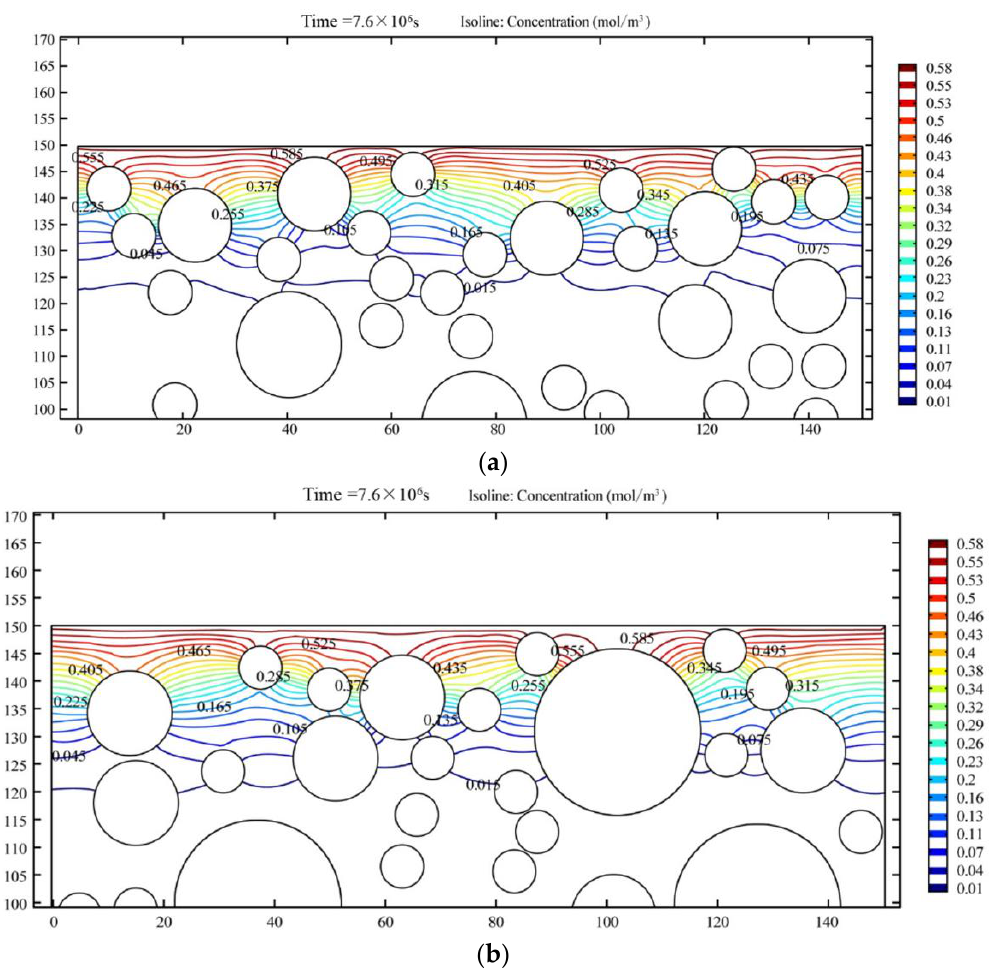
Figure 18. Chloride ion concentration distribution of specimen HPC50 with different sizes: ( a ) Size 1; ( b ) Size 2.